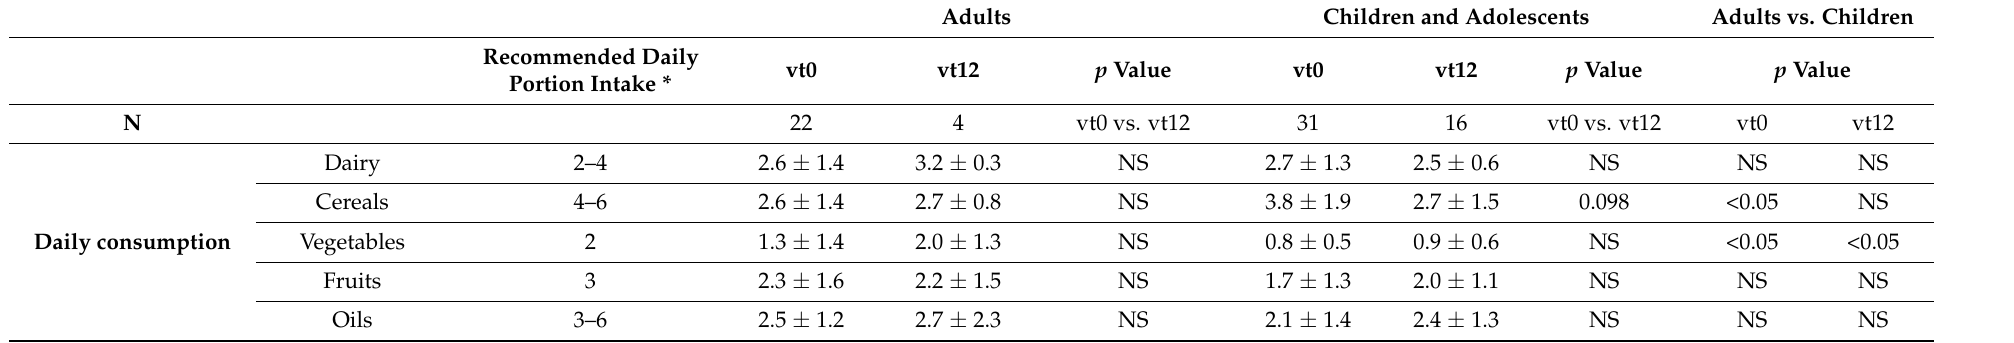
Table 2. Food group consumption frequency of celiac adults and children that took part in the study (mean ±